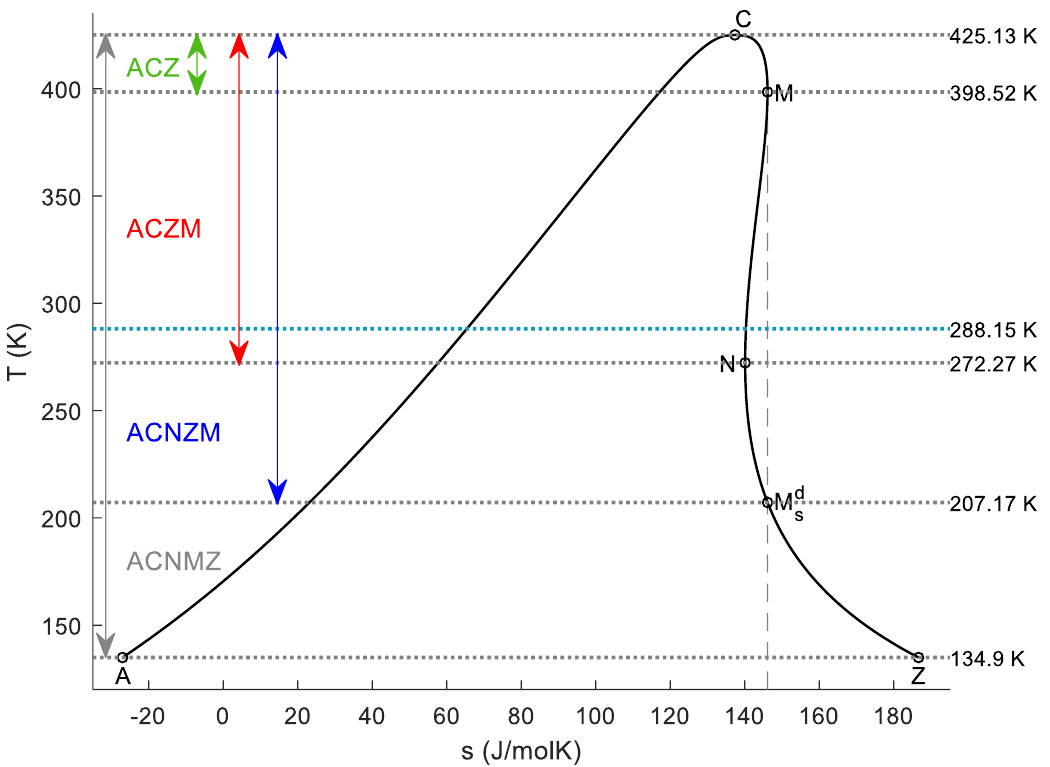
Figure 2. Temperature–specific entropy ( T – s ) diagram of butane, showing the classification in the full fluid-range (from the triple point to the critical point) as well as the classification (and related characteristic points) in various confined temperature ranges (colored arrows and letters). The blue dotted line shows ambient temperature (15 °C). T – s data taken from the NIST Webbook [13]. From these five characteristic points, one can theoretically construct 3! + 4! + 5! = 6 + 24 + 120 sequences containing only the primary points (A, C, and Z) or the primaries plus M (A, C, Z, and M) or finally all the five points (A, C, Z, M, and N); it is an enormous number to replace